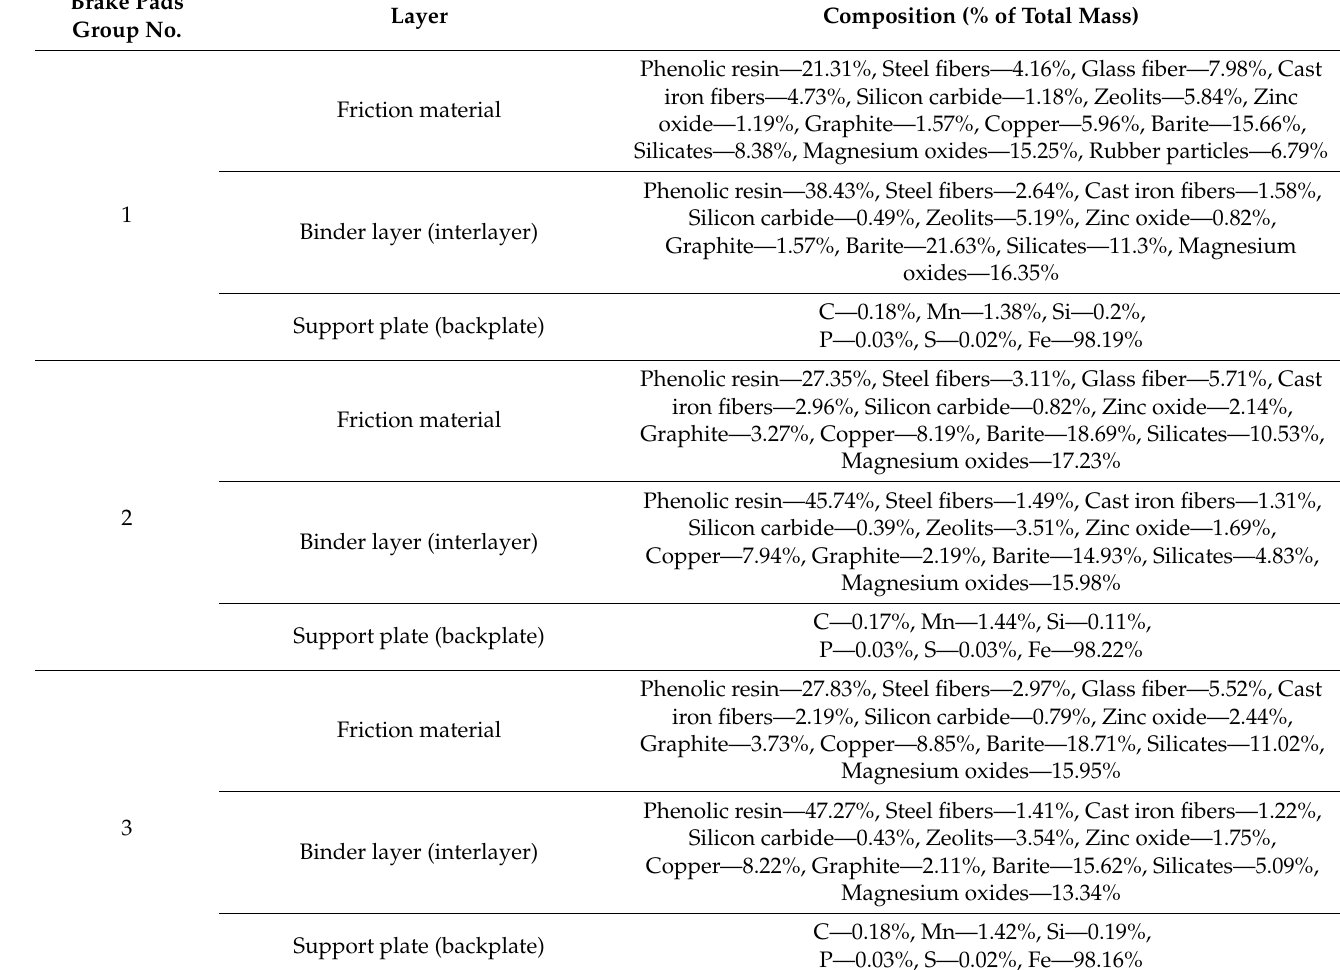
Table 1. Composition of individual samples and their